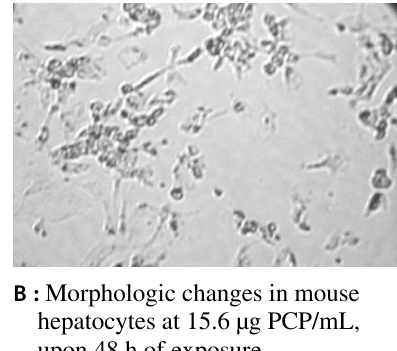
upon 48 h of exposure. Figure 3. Morphologic changes in AML 12 mouse hepatocytes treated with